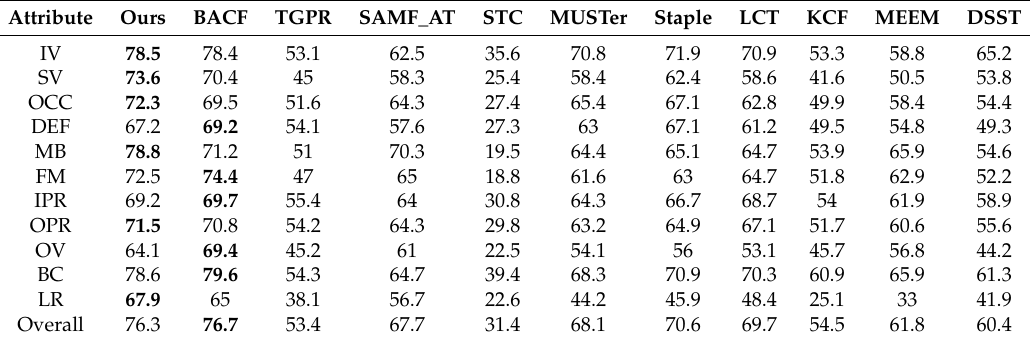
Table 2. Comparison of our tracker with other state-of-the-art trackers on 11 different attributes of the OTB-2015 dataset. Average success scores (%) at a threshold of 0.5 are presented. The optimal results are highlighted in bold.